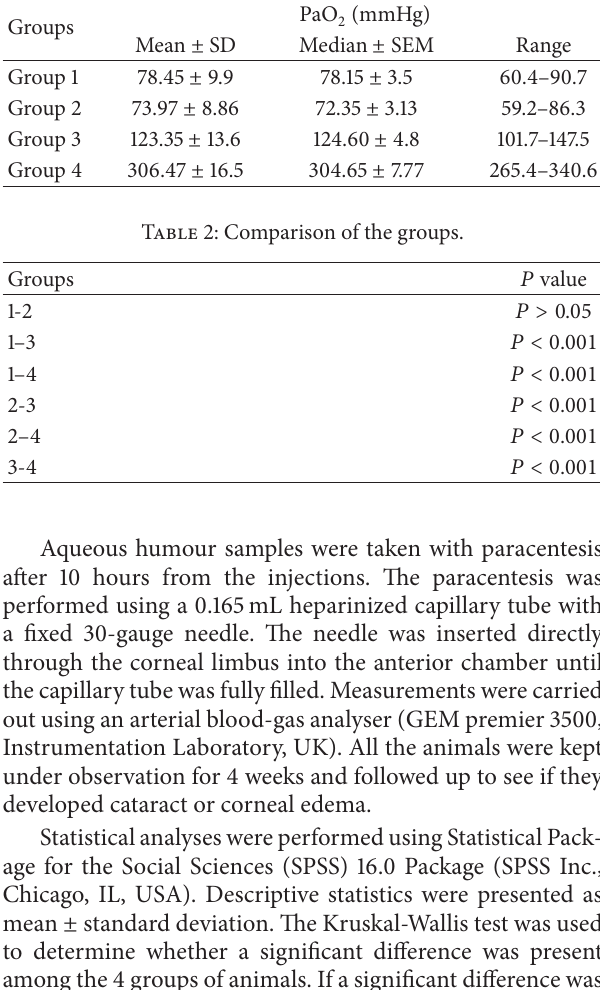
Table 1: Aqueous humour PaO